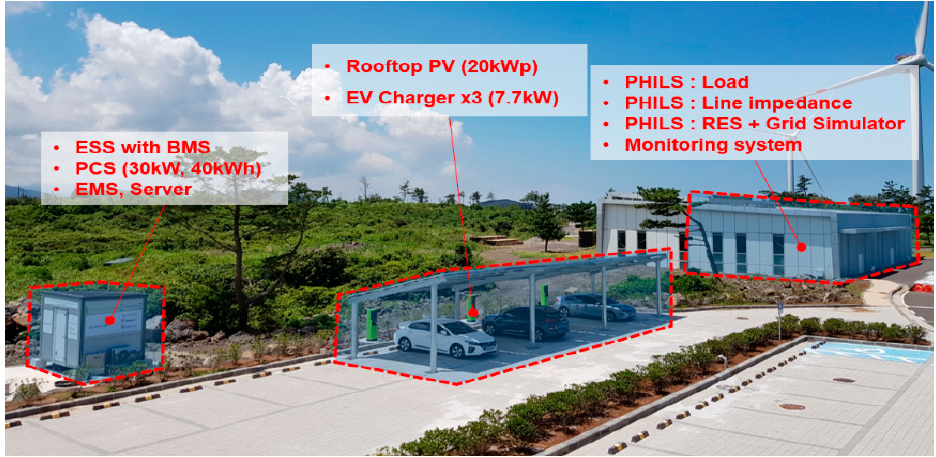
Figure 9. EV Charging infrastructure test site.